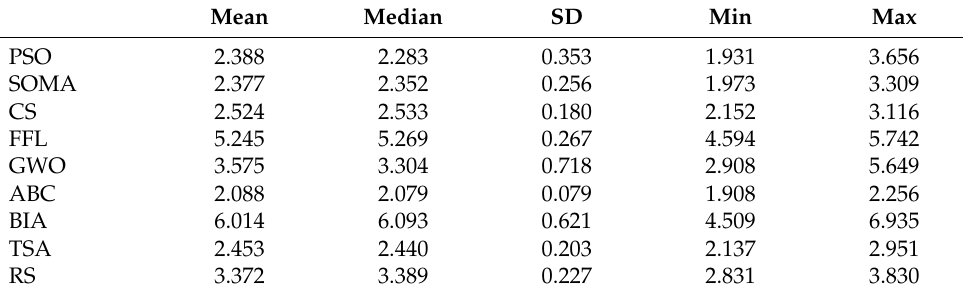
Table 3. Comparison of algorithms for Function f 3 .